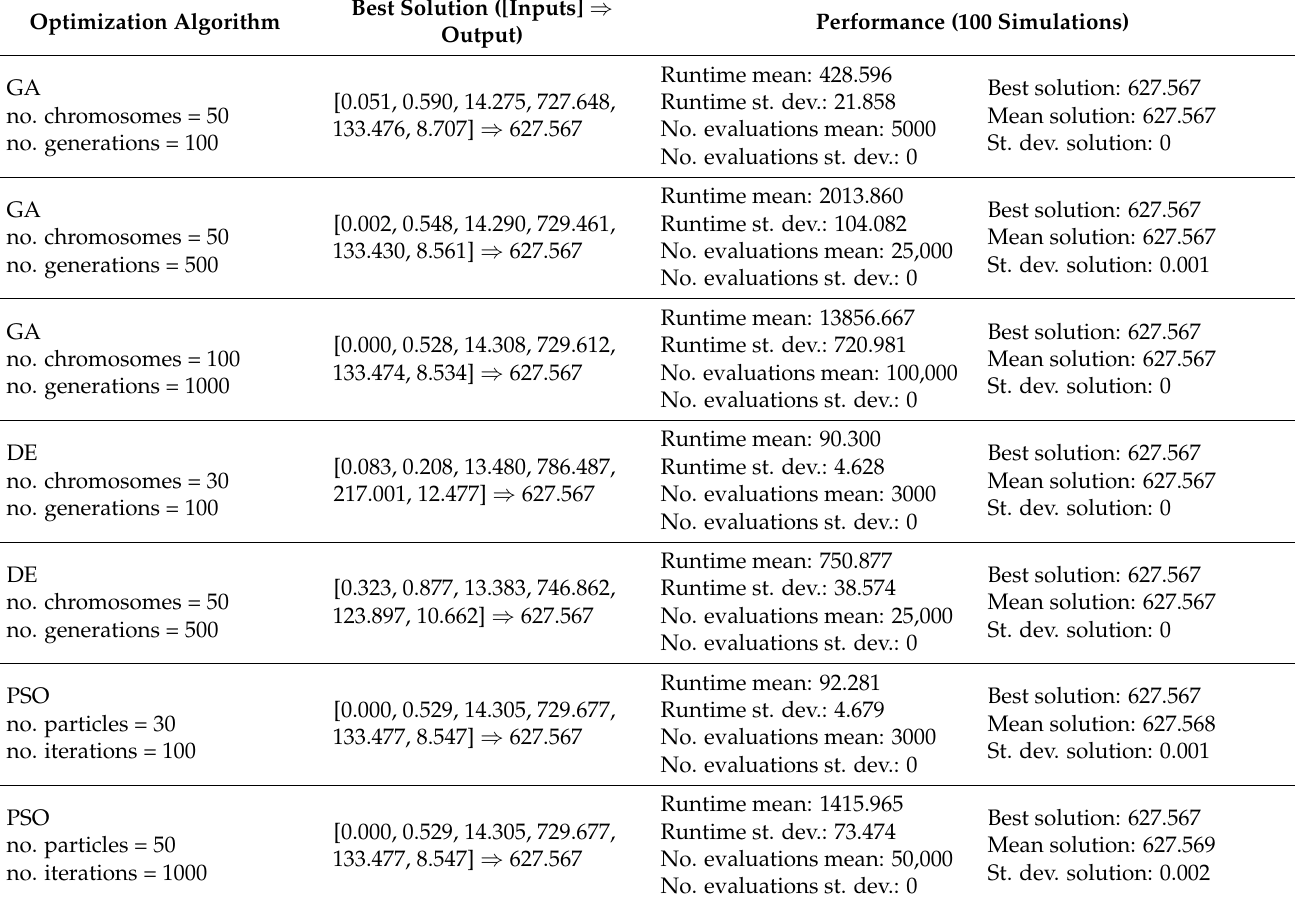
Table 5. Results obtained with classic optimization algorithms for CO (mg/m 3 ). Optimization